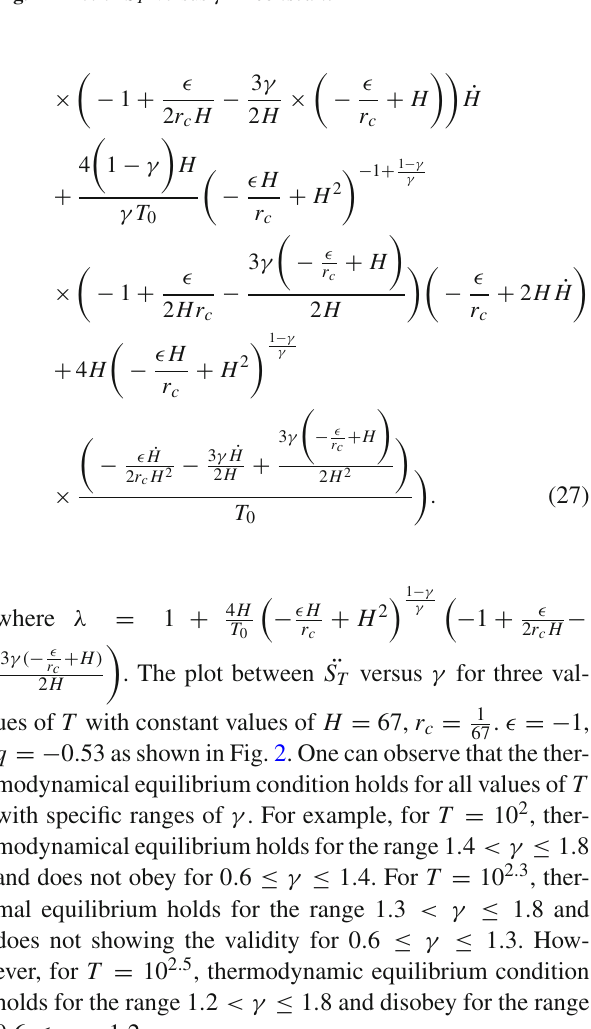
Fig. 1 Plot of total entropy versus γ Fig. 2 Plot of ¨ S T versus γ =